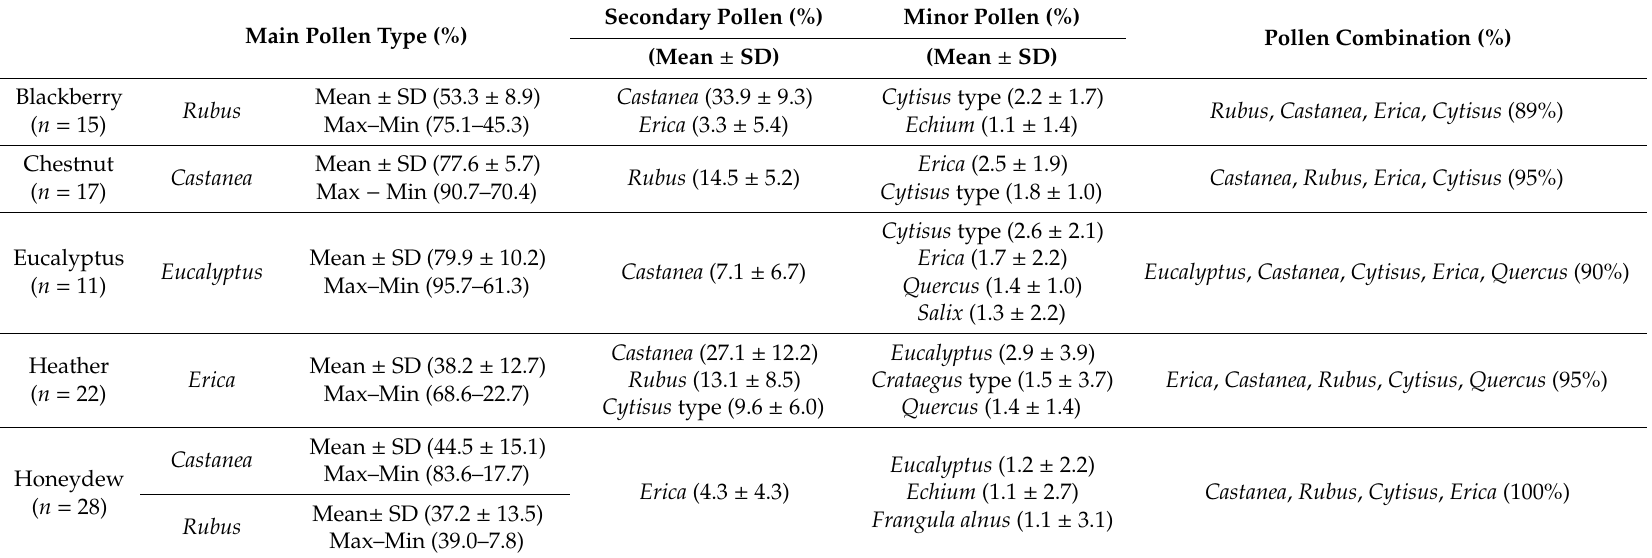
Table 1. Palynological profile of the studied honey